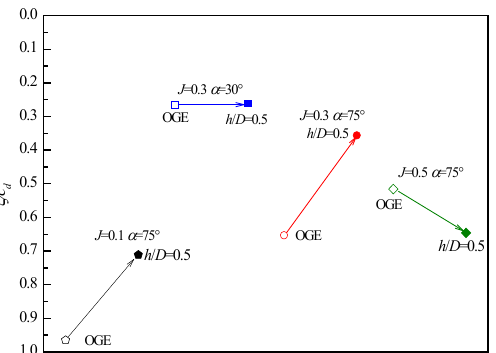
Figure 28. Pressure coefficient contour and streamlines on symmetry plane under different condi- tions: ( a ) J = 0.3, α = 30°; ( b ) J = 0.1, α = 75°; ( c ) J = 0.3, α = 75°; ( d ) J = 0.5, α = 75°.